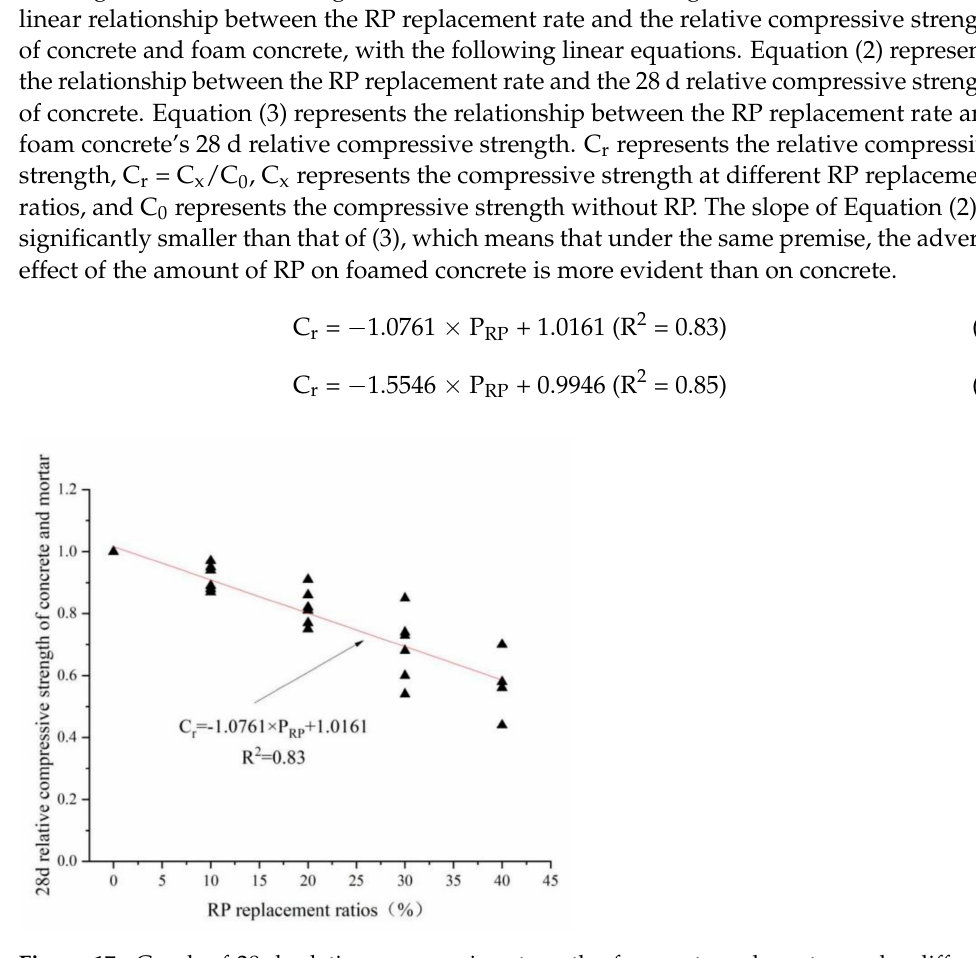
Figure 17. Graph of 28 d relative compressive strength of concrete and mortar under different replacement rates of RP